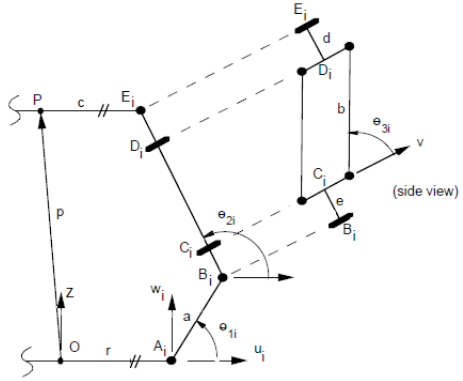
Figure 3. Side view of the i -th kinematic chain (Figure 2, [4]). The coordinate frame ( x, y, z ) is attached to the center of the stationary platform. The origin (the center of the stationary platform) is labeled point O , and the center of the moving platform is labeled point P . p is the vector from the center of the stationary platform to the center of the moving platform. The distance from the center of the stationary platform to the lowest joint (joint A i ) is denoted r , and the distance from the center of the moving platform to the highest joint (joint E i ) is denoted c . The lengths of the links are labeled a , b , d , and e . The angular positions of links A i , B i , and C i are given by ϴ 1i , ϴ 2i , and ϴ 3i , respectively. A coordinate frame ( u i , v i , w i ) is defined for each kinematic chain, attached at point A i .